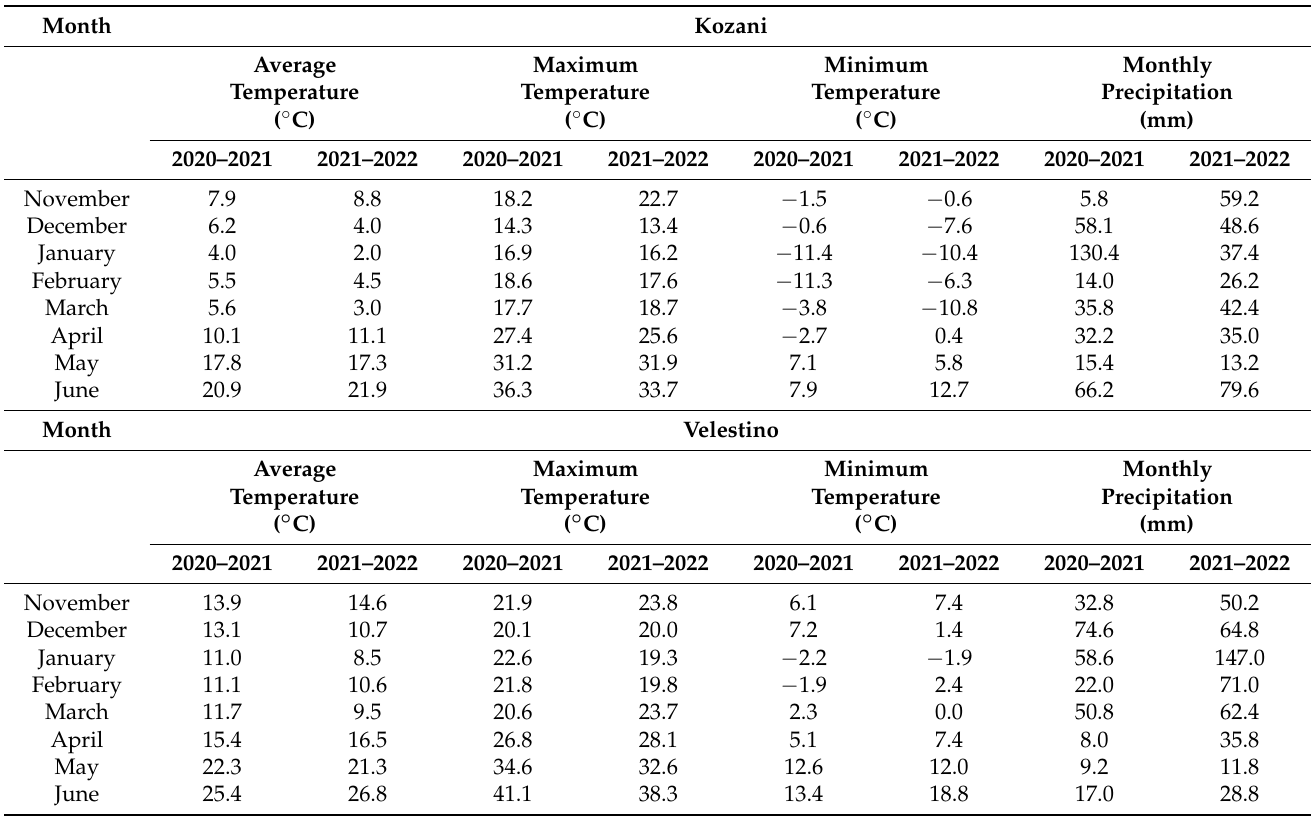
Table 1. Climatic conditions in the two experimental fields during the 2020–2021 and 2021–2022 growing